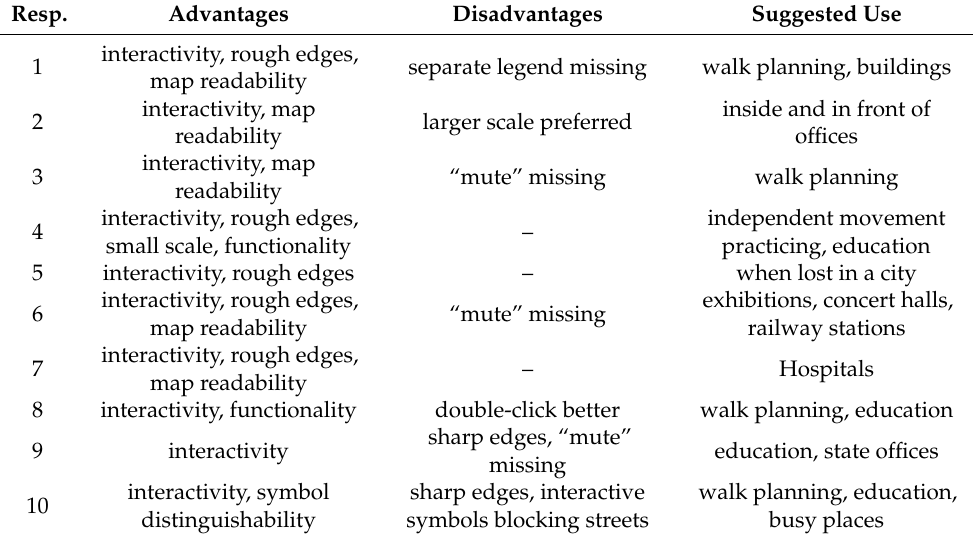
Table 3. Results of the final part (interview) of the user